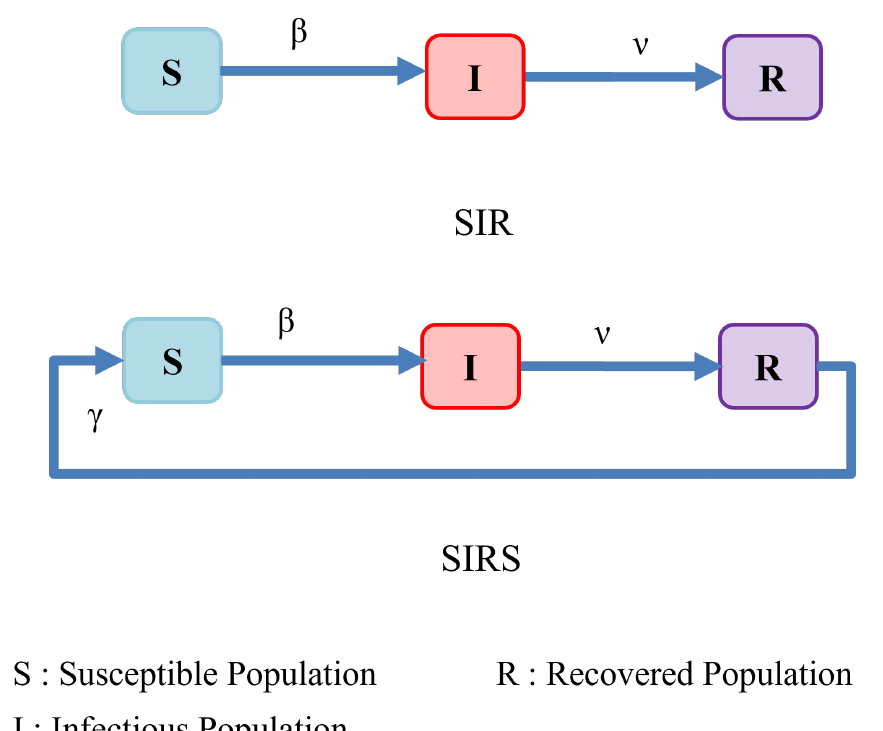
Figure 1. Classic SIR and SIRS